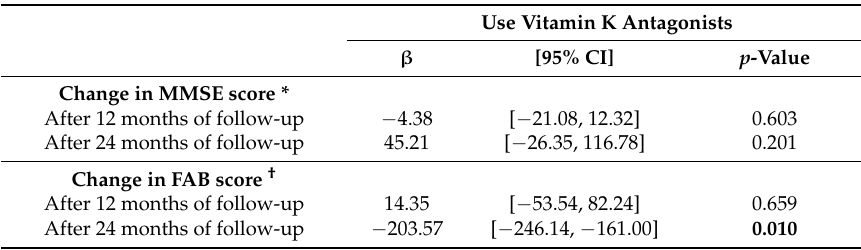
Table 3. Fully adjusted linear regressions examining the association between the use of vitamin K antagonists (independent variable) and changes in cognitive scores, as percentages, during follow-up (dependent